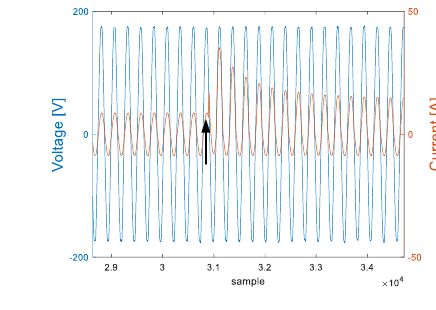
( a ) Section A: RL turned ON. ( b ) Section B: universal motor turned ON.